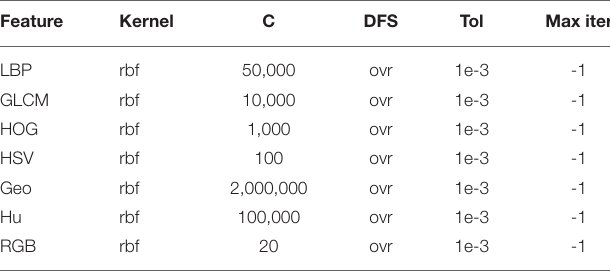
TABLE 5 | Classifier classification performance evaluation